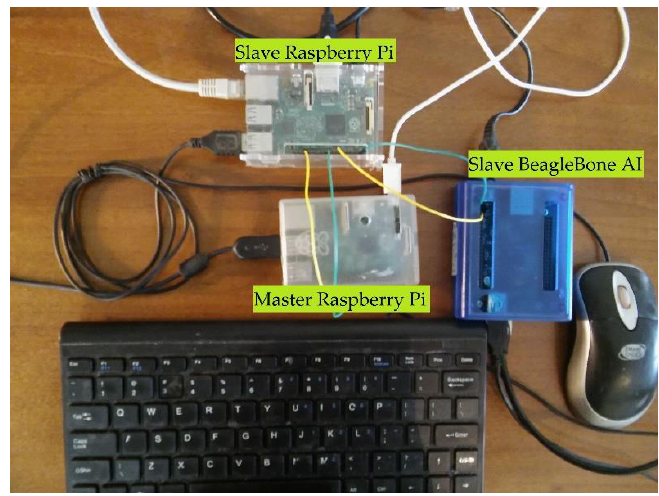
Figure 7. The system hardware experimental setup: RPi3 to RPi3 and RPi3 to BBAI.